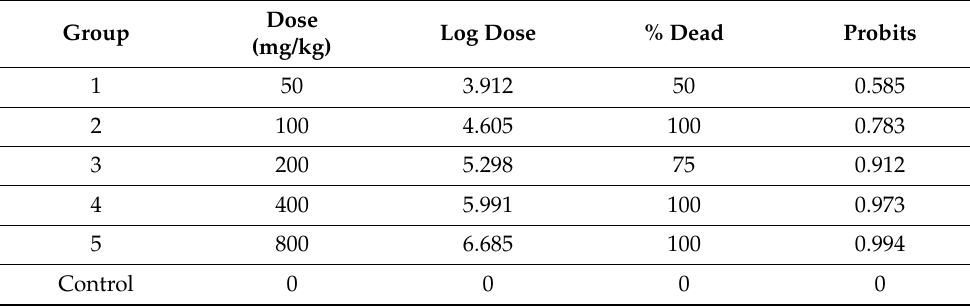
Table 1. Determination of the lethal doses of gold complex for the determination of LD50 after intraperitoneal injection in rats ( n = 24, 4 in each group). Dose Group Log Dose % Dead Probits (mg/kg) 1 50 3.912 50 0.585 100 4.605